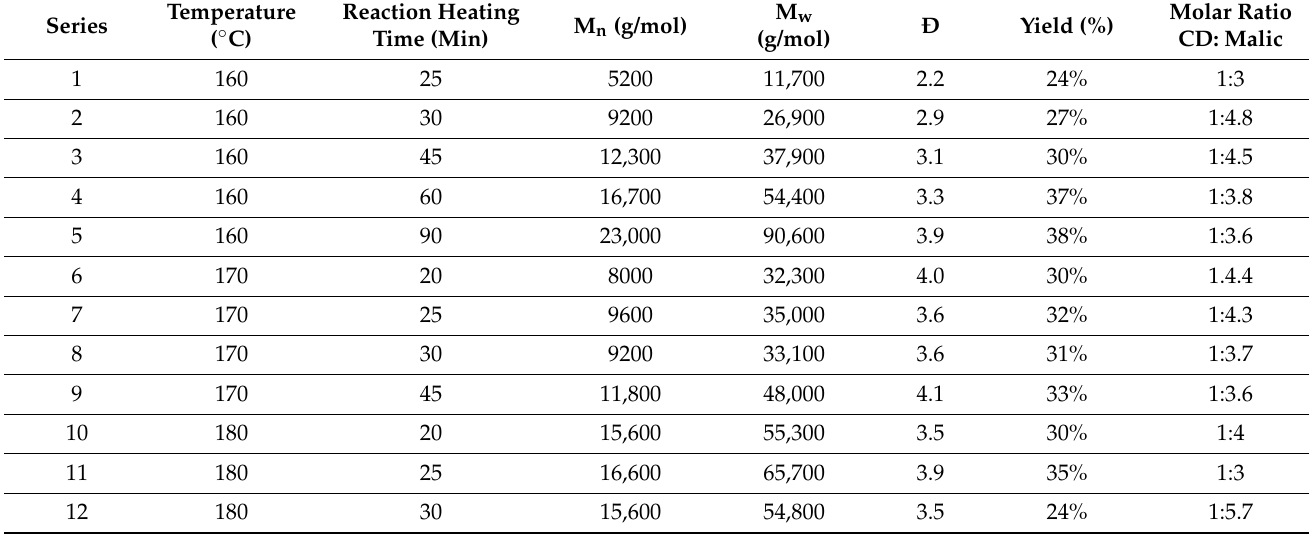
Table 1. Characteristics of the CD-MO oligomers as a function of the reaction time and temperature, as well as the molar ratio between the reactants, CD and malic